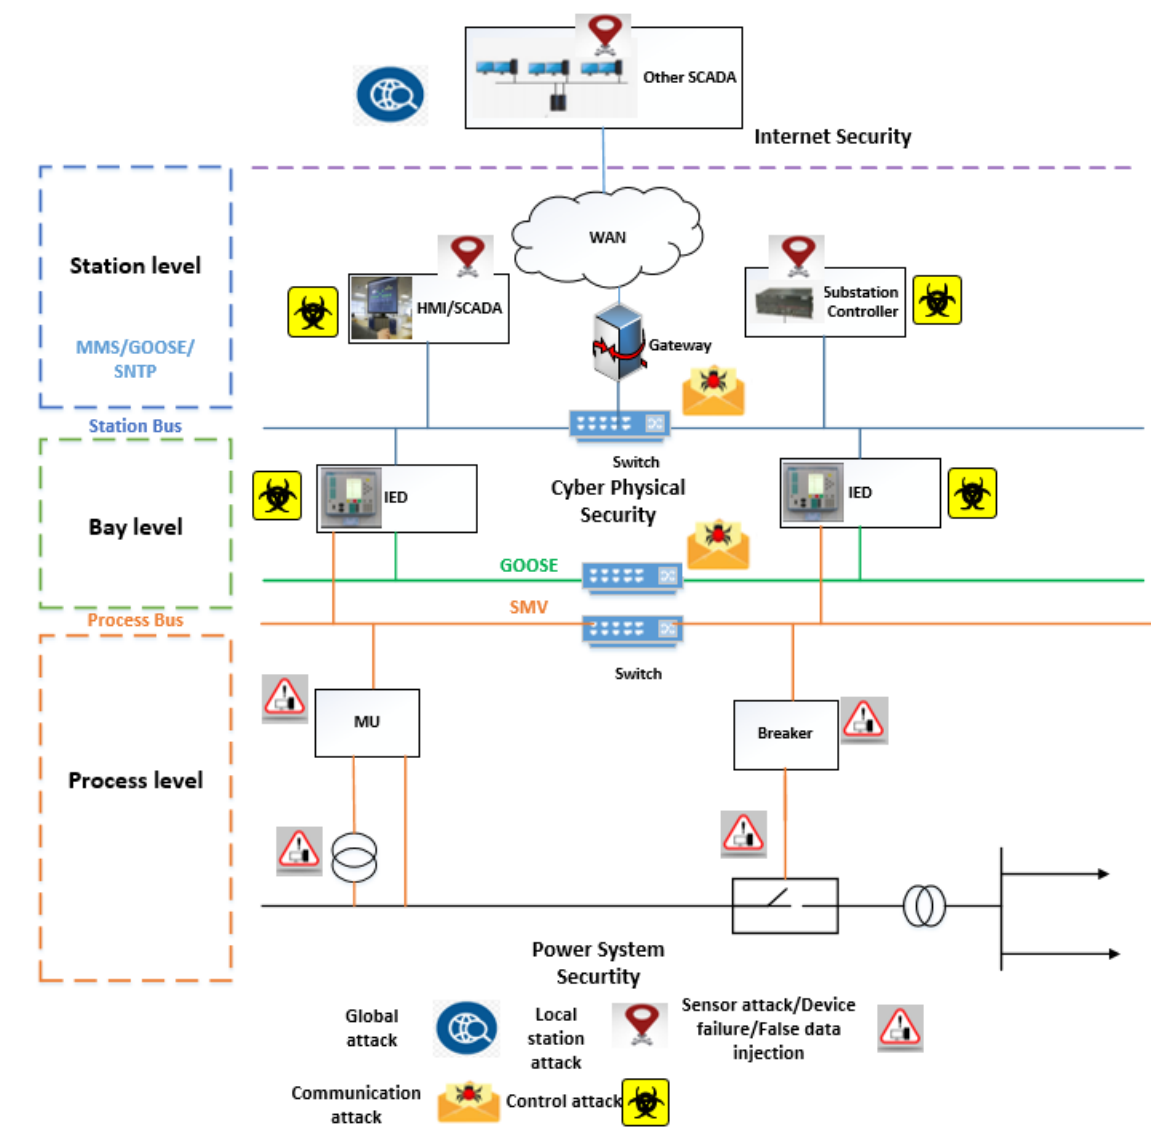
Figure 4. Security threat classification for different levels of IEC 61850 [27].